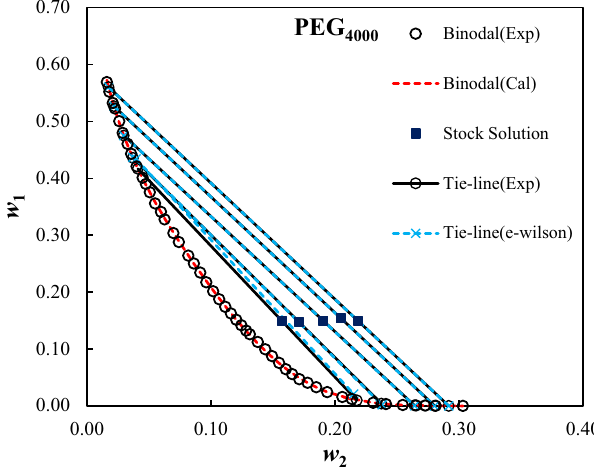
Figures 7. Like Fig. 5 for PEG 4000 (1) + trilithium citrate (2) + water (3) ATPSs.